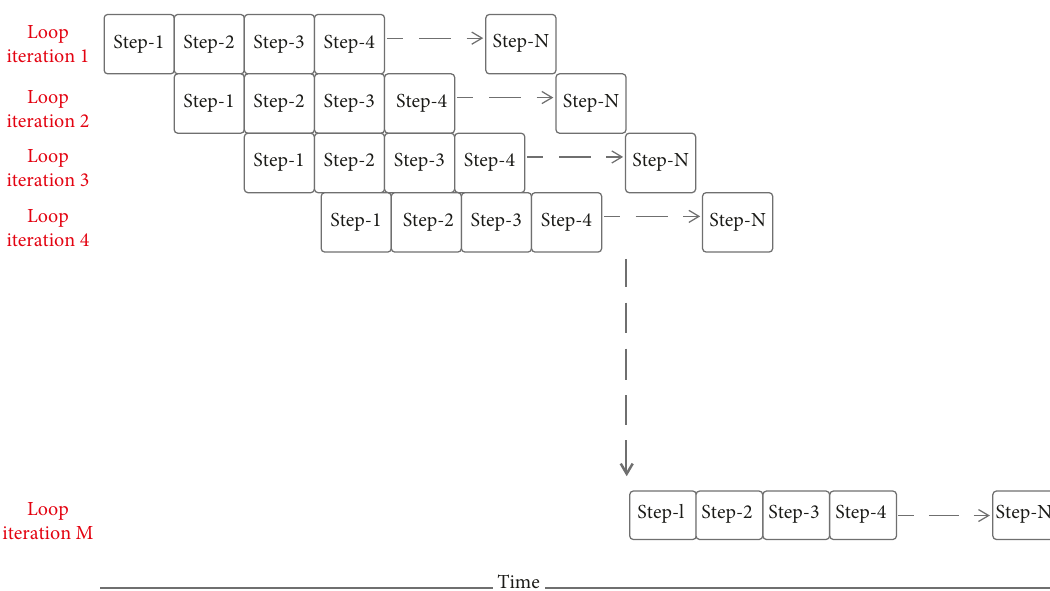
Figure 2: The pipelined data created by the Intel FPGA